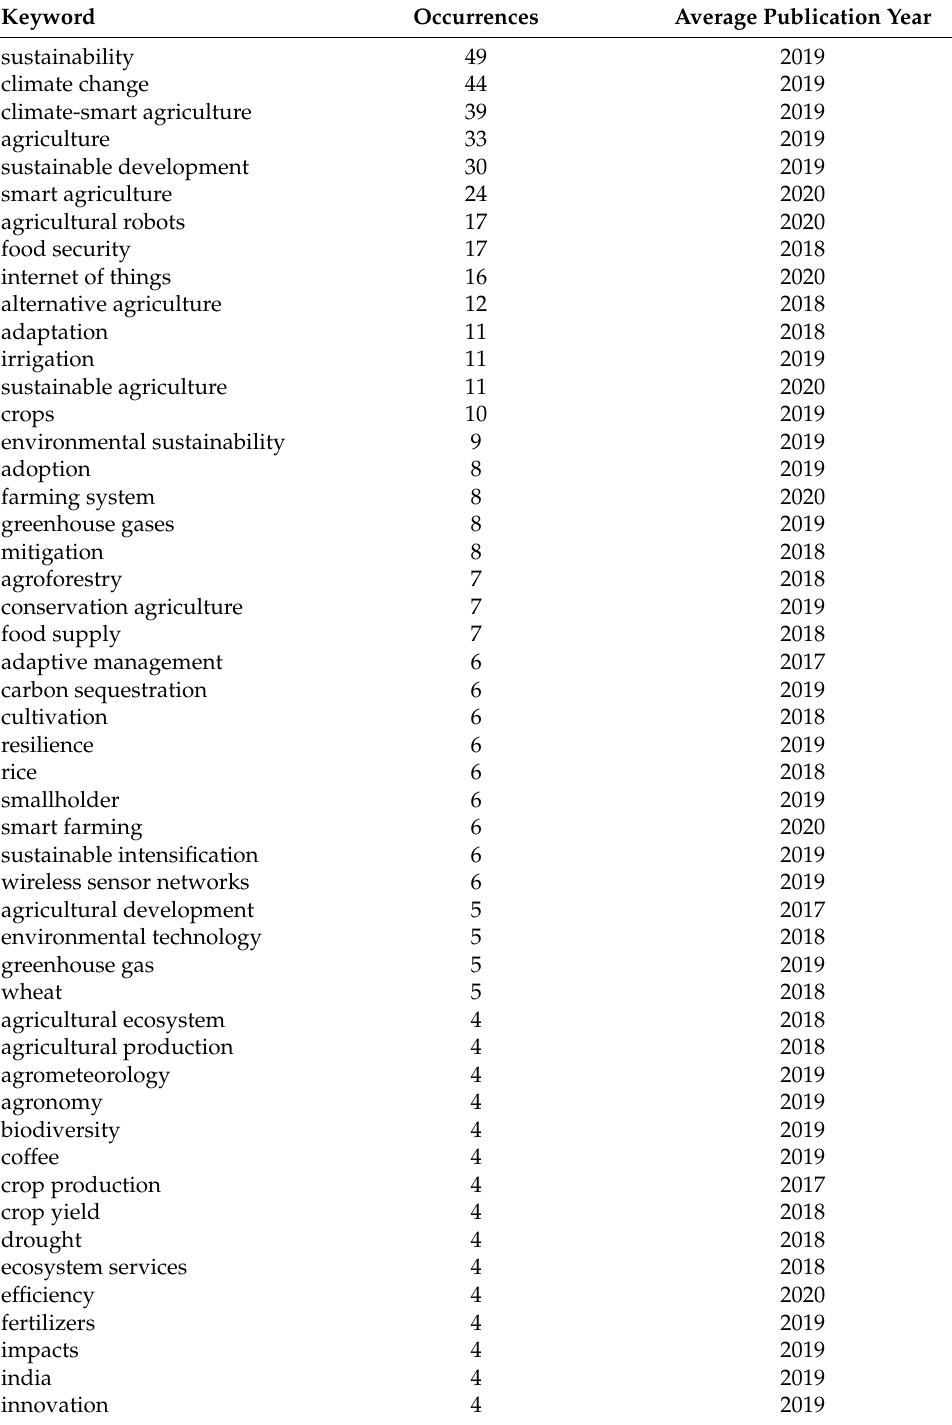
Table 1. Top 50 keywords for the topics ‘smart agriculture’ and